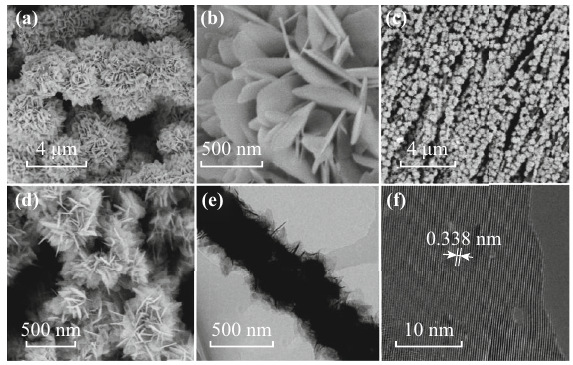
Fig. 3 XRD patterns of NC@SnO 2 , SnO 2 , and NC. (Color figure